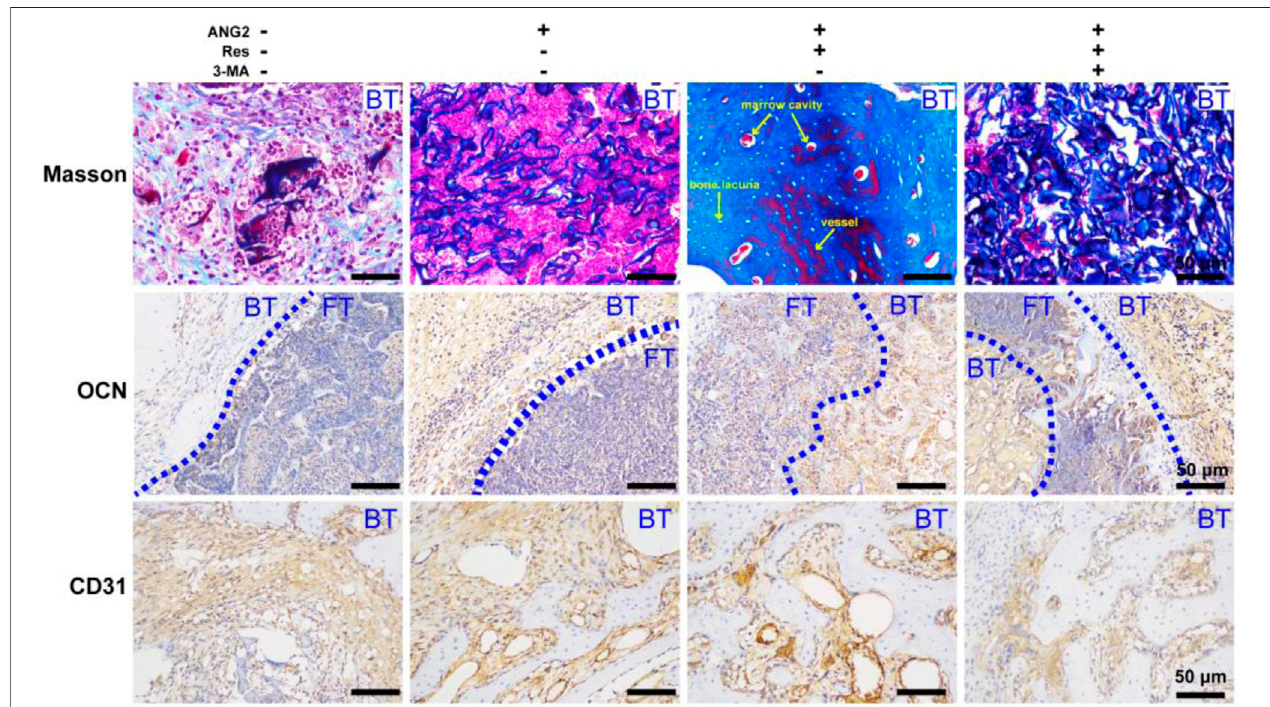
FIGURE 8 | Masson staining and immunohistochemical staining for OCN and CD31 in the bone defect area at the 8th week; FT indicates “ fi ber texture ” , and BT indicates “ bone tissue ” . The values are represented as the mean ± SD ( n (cid:1) 6).